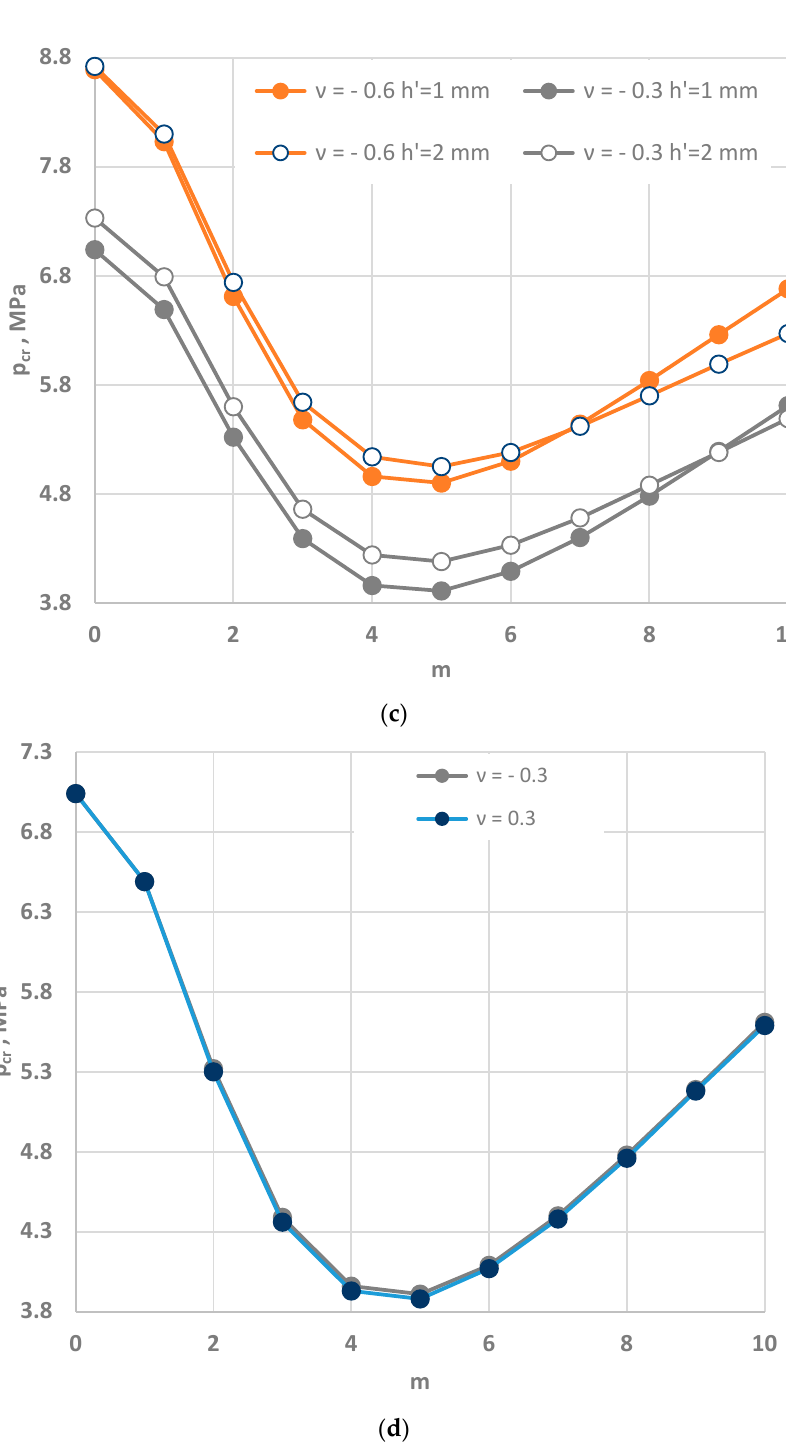
Figure 2. Critical static load p cr distribution versus mode m for plates radially compressed on the outer edge: with facing thickness h ′ = 1 mm ( a ), with facing thickness h ′ = 2 mm ( b ), with two thicknesses of auxetic facings ( c ), with auxetic and conventional facings ( d ).